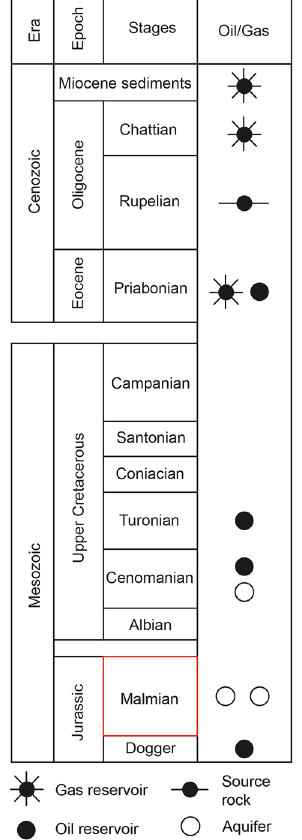
Fig. 7 Time stratigraphic table of the Austrian part of the Alpine Foreland Basin. The German part of the basin also includes the Barremian, Hauterivian, and part of the Berriasian stages of the Lower Cretacerous. The Malmian strata (outlined in red), is targeted for geothermal energy production in the MB. Source rock, oil and gas occurrences are indicated after Grunert et al. (2015); Nachtmann and Wagner (1987). Figure adapted from Pytlak et al.